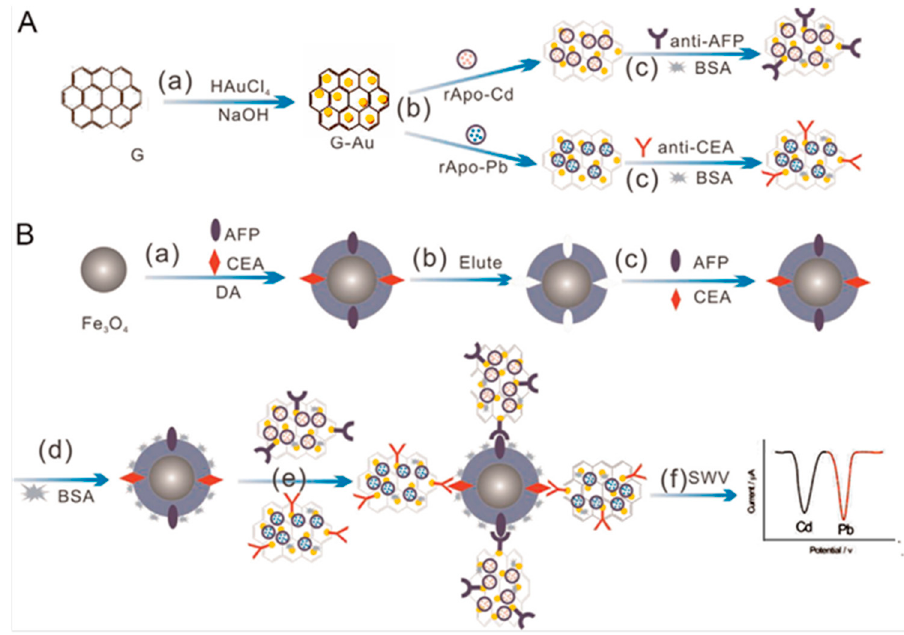
Figure 8. Scheme of the multiplexed electrochemical immunosensor for the simultaneous determination of AFP and CEA. Preparation of signal tags ( A ); preparation of MMIP and capture of AFP and CEA antigens followed by immunocomplexation and electrochemical detection ( B ). Reprinted from [43] with permission.